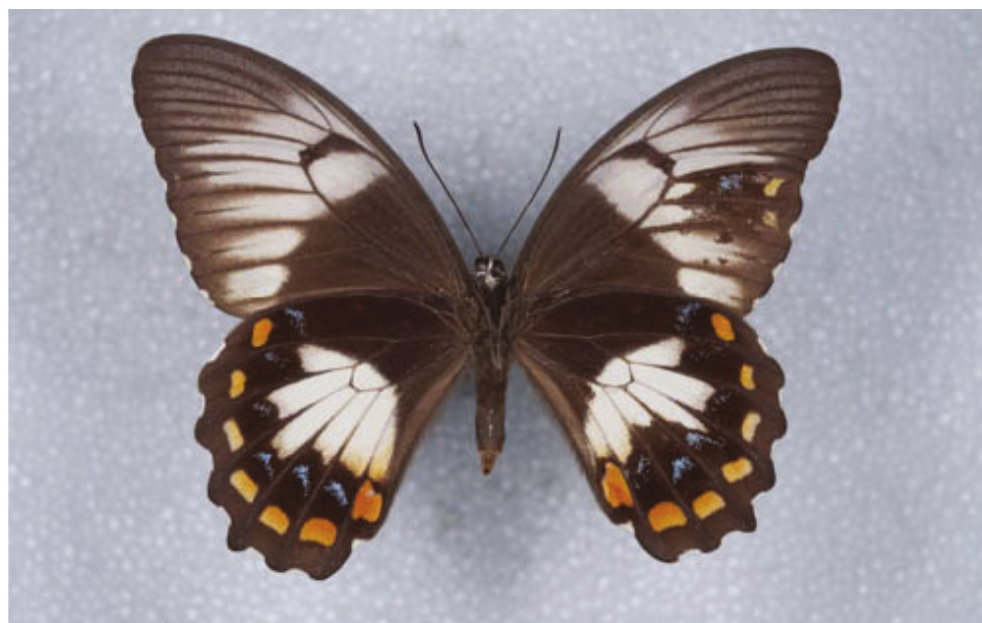
Figure 1. The homeotic specimen of Papilio aegeus ormenus , showing the undersides of the wings. The homeotic aberration is bordered by the discocellular cell and veins M tern on the hindwing is independent of the homeotic markings on the forewings, and is more likely caused by damage sustained by the pupa during ecdysis from the fifth